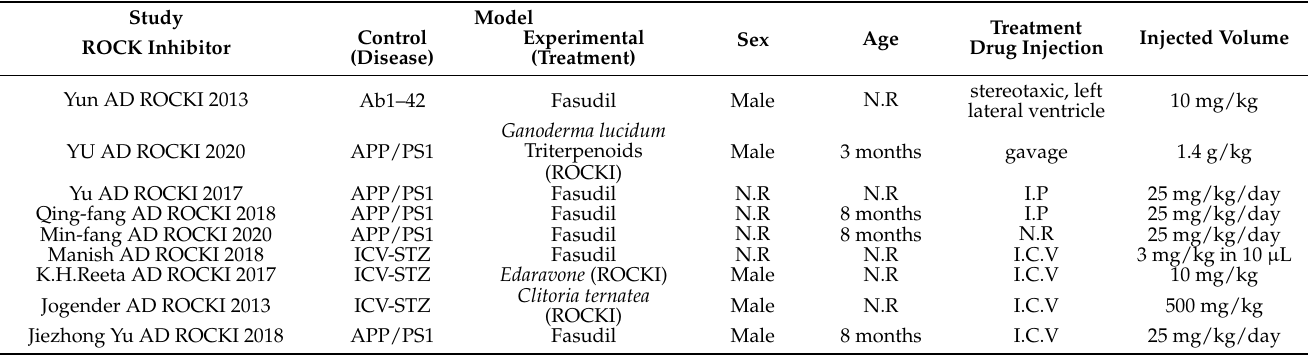
Table 2. Baseline characters for the control group and experimental groups extracted from the selected